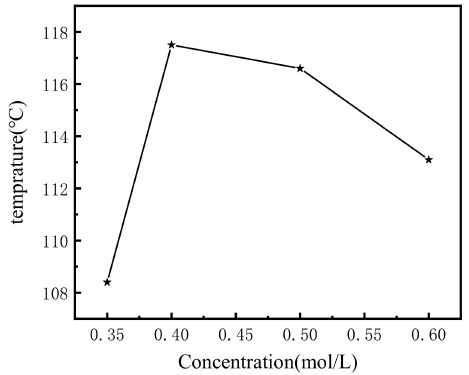
Figure 2. Plot of T gel of with different